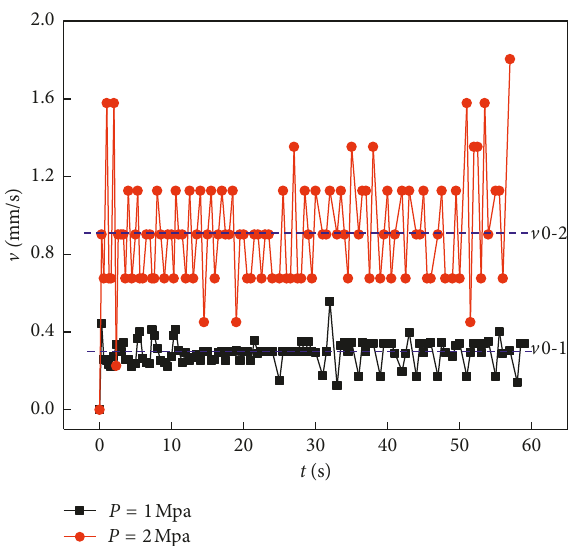
6: The variation curve of seepage velocity with the variation of seepage pressure in different